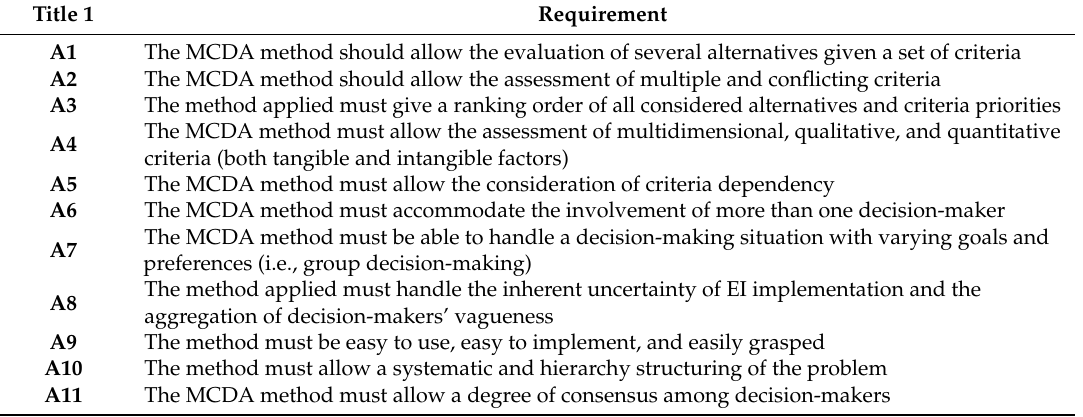
Table 1. Requirements for the multi-criteria decision analysis (MCDA) method applied in the risk assessment process.